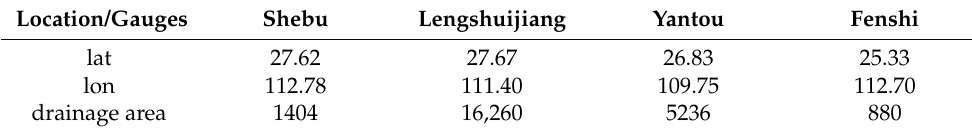
Figure 6. Simulated and observed streamflow at the four gauges. Table 2. Locations of four